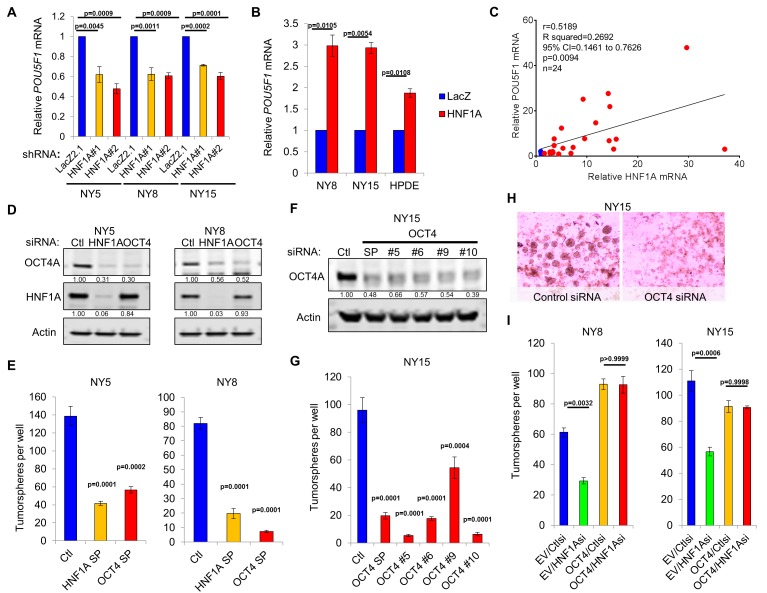
HNF1A regulates stemness through POU5F1/OCT4 regulation.(A) qRT-PCR analysis of POU5F1/OCT4 mRNA in NY5, NY8 and NY15 cells expressing control (LacZ2.1) or HNF1A shRNAs. ACTB was used as an internal control, n = 3. Statistical difference was determined by one-way ANOVA with Dunnett’s multiple comparisons test. (B) LacZ or HNF1A was induced in NY8, NY15 or HPDE cells with doxycycline for 6 days. Levels of POU5F1/OCT4 mRNA were measured by qRT-PCR with ACTB as an internal control, n = 3. Statistical difference was determined by unpaired t test with Welch’s correction. (C) Pearson correlation coefficient of POU5F1/OCT4 and HNF1A mRNA levels from NY PDA cells (n = 22, red) relative to HPNE and HPDE (blue) cells. (D) Western blot of OCT4A and HNF1A protein in NY5 and NY8 cells transfected with POU5F1/OCT4 (labeled OCT4) or HNF1A SMARTpool siRNA for 3 days. Quantitation of proteins is indicated below the respective blots. (E) NY5 and NY8 cells were transfected with HNF1A or POU5F1/OCT4 SMARTpool siRNA for 3 days and then grown in tumorsphere media on non-adherent plates (1500 cells/well). Spheres were quantitated 7 days later, n = 3. Statistical difference was determined by one-way ANOVA with Dunnett’s multiple comparisons test. (F–H) NY15 cells were transfected with POU5F1/OCT4 SMARTpool (SP) siRNA or individual sequences for 3 days and either harvested to assess OCT4A knockdown by Western blot (F) or grown in tumorsphere media on non-adherent plates (1500 cells/well) (G). Spheres were quantitated 7 days later, n = 3. Statistical difference was determined by one-way ANOVA with Dunnett’s multiple comparisons test. Representative spheres are shown in (H). (I) NY8 and NY15 cells transduced with OCT4A (labeled OCT4) or empty vector control (EV) were transiently transfected with control (Ctl) or HNF1A-targeting siRNA for 72 hr, and then grown in tumorsphere media on non-adherent plates (1500 cells/well). Spheres were quantitated 7 days later, n = 3. Statistical difference was determined by one-way ANOVA with Tukey’s multiple comparisons test. Related data can be found in Figure 6—figure supplements 1 and 2.10.7554/eLife.33947.026Figure 6—source data 1.Quantitation of OCT4/POU5F1 mRNA following HNF1A knockdown and overexpression; relative HNF1A and OCT4/POU5F1 mRNA expressions in PDA cells; quantitation of tumorspheres following OCT4/POU5F1 knockdown; and quantitation of tumorsphere formation following OCT4A rescue.10.7554/eLife.33947.027Figure 6—source data 2.Quantitation of ChIP, CLuc activity, annexin V staining, PI staining, and tumorsphere formation.